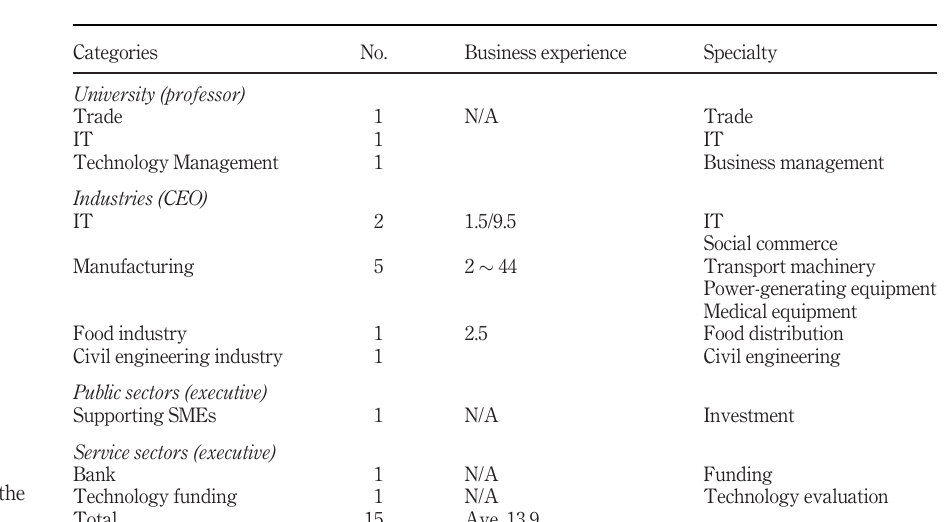
Figure 1. Operation model